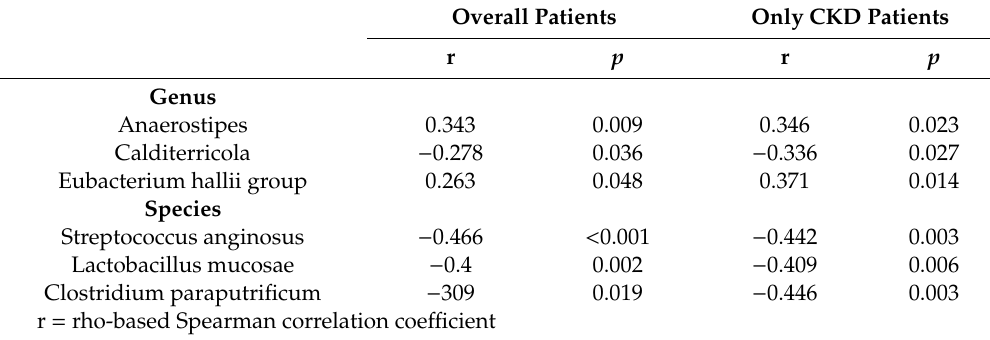
Table 3. Correlation between relative abundances of microbes and daily protein intake. Overall Patients Only CKD Patients